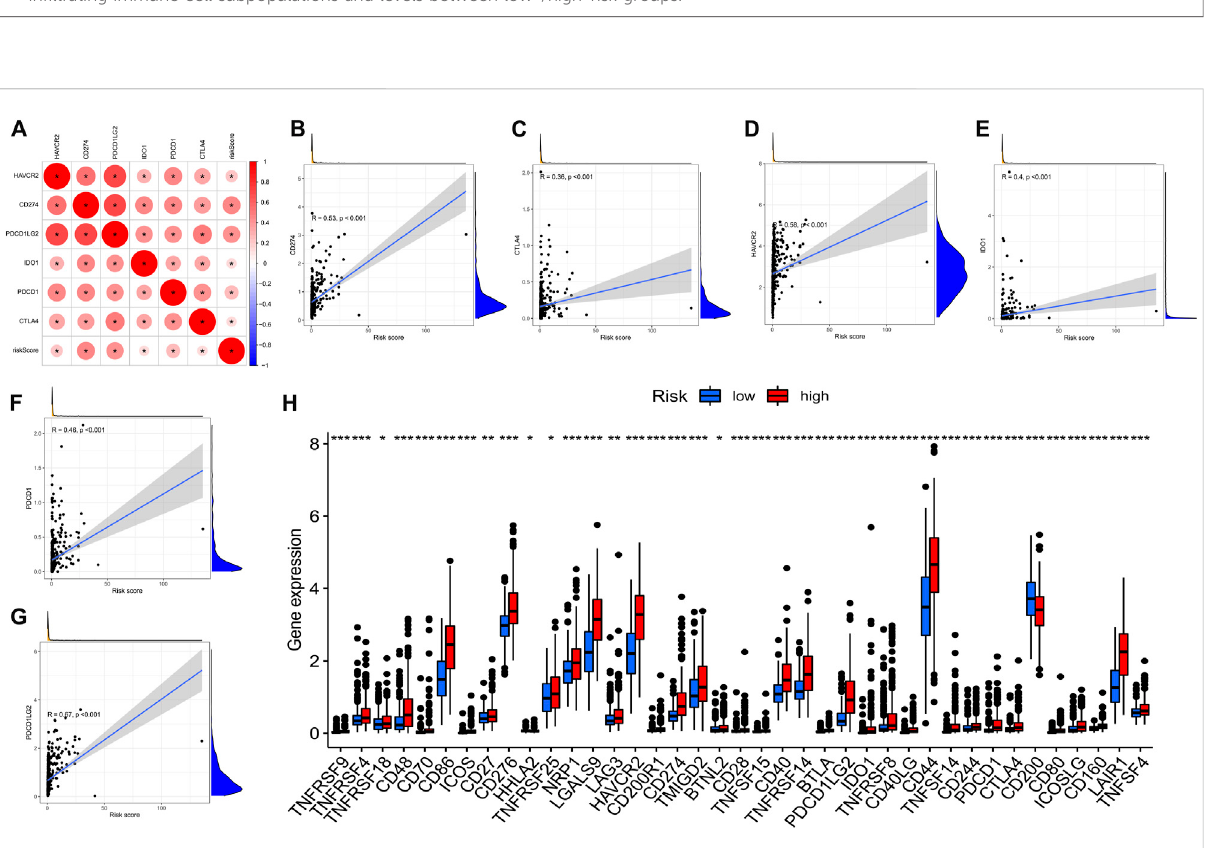
FIGURE 9 | Comparison of ImmuneScore, StromalScore, ESTIMATEScore, and TumorPurity among low- and high-risk groups. (N) . Enrichment of 29 immunological markers in low-/high-risk subgroups shown with a heatmap. (O) . A heatmap of 29 immunological markers and their associated immune scores for two distinct groups. (P) . Differentiation of immunological signature enrichment between the two groups. (Q) . Difference of in fi ltrating immune cell subpopulations and levels between low-/high-risk groups.